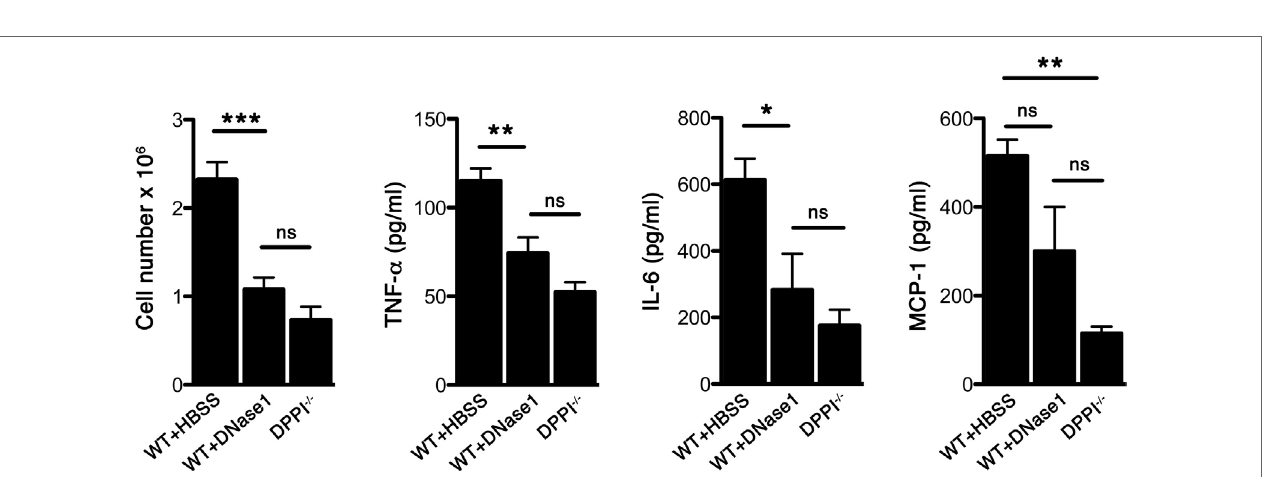
FigUre 3 | Dnase 1 treatment suppresses the acute sev-induced inflammatory responses . WT and DPPI − / − mice were infected with Sev and their BALF harvested on day 3 PI. Some WT mice received DNase 1 i.n. on days 0–2 PI. The cells were enumerated and cell-free BALF assayed for cytokines by CBA. Values represent mean ± SEM, n = 4–5 mice per genotype/treatment group. * P < 0.05, ** P < 0.01, *** P < 0.001, ns = not significant.